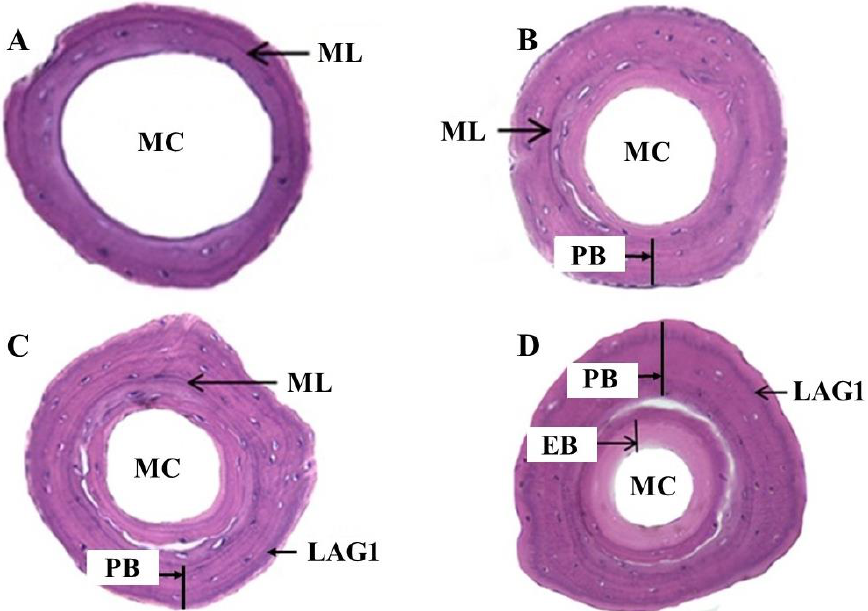
Figure 2. The phalangeal cross-section of laboratory-reared juvenile K. borealis by growth stage; ( A ) immediately after the metamorphosis; ( B ) before the first hibernation; ( C ) immediately after the first hibernation; ( D ) before the next hibernation. ML = metamorphosis line; MC = marrow cavity; PB = periosteal bone; EB = endosteal bone; LAG = line of arrested growth.